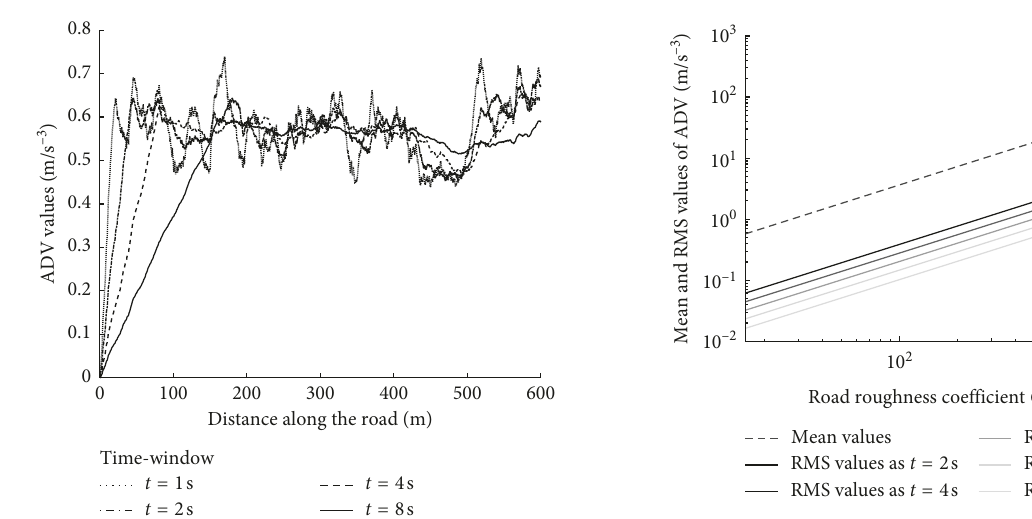
Figure 4: ADV values calculated at different